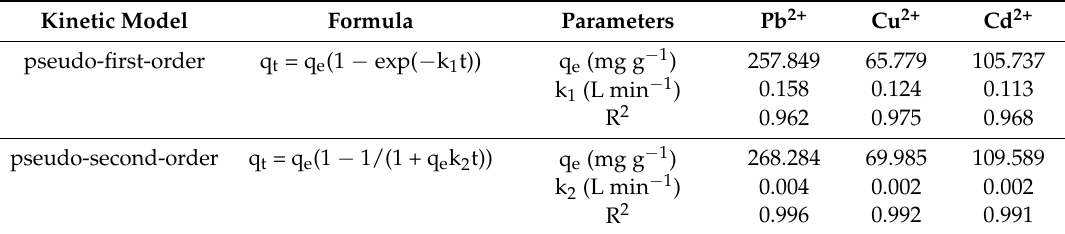
Table 1. Kinetic parameters for Pb 2+ , Cd 2+ , and Cu 2+ ions adsorption on the mp-CA/GO.